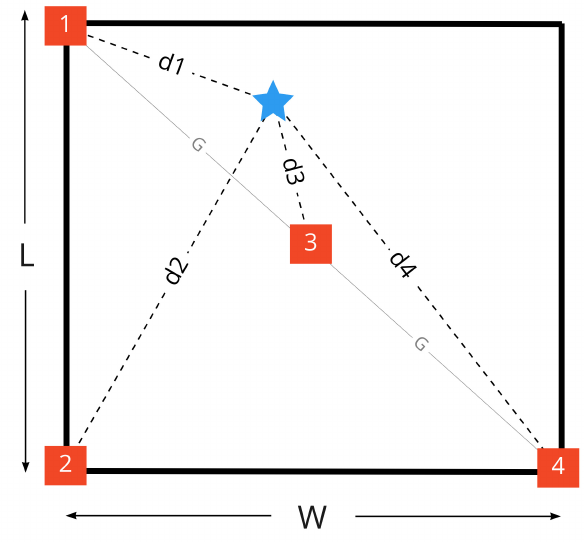
Figure 10. Relative distances to the target